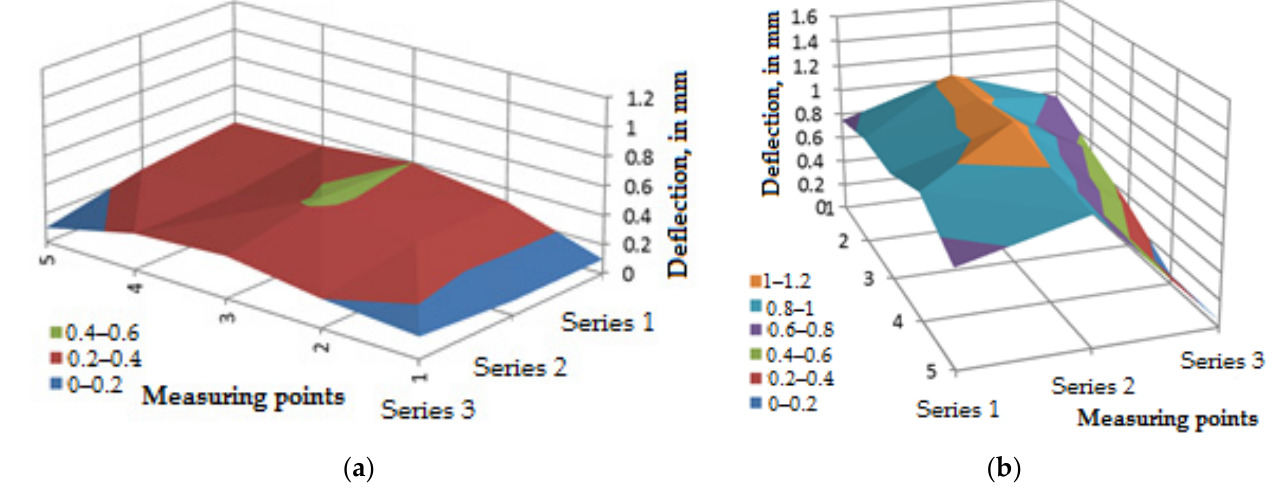
Figure 10. Deflection values and warpage of blockboard with HDF faces tested in the climatic chamber: ( a ) at the beginning of the experiment; ( b ) after three months of exposure in the climatic chamber.